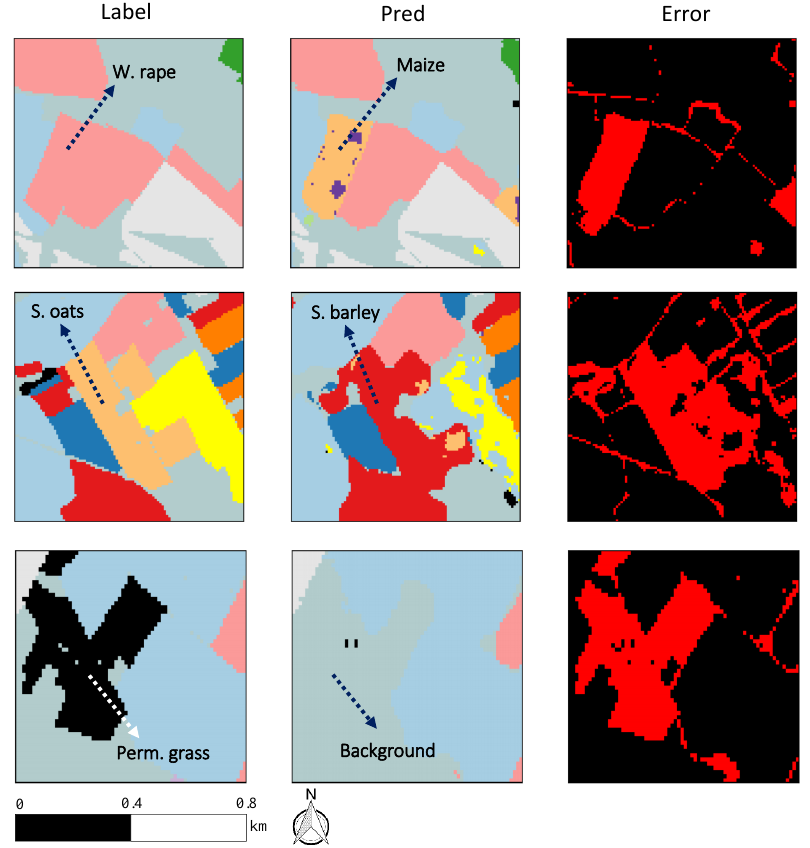
Figure 13. Some areas which were classified with high confidence by the proposed network, whilst these fields likely had wrong label in the reference images. The color legends are similar to Figure